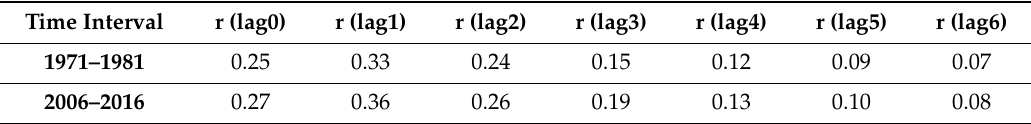
Table 1. Correlation coe ffi cients between rainfall and drainage at di ff erent lag time (in days) for the period of minimum (1971–1981) and maximum urbanization